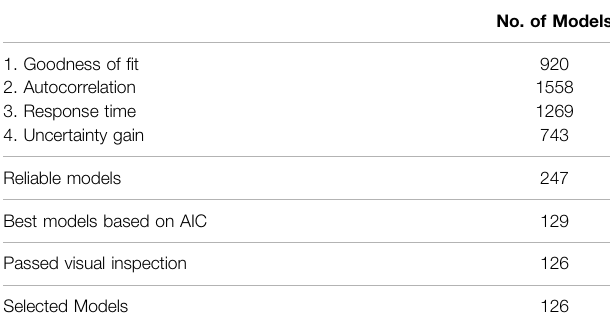
TABLE 2 | Results for the reliability and selection criteria for all 2000 time series models for 250